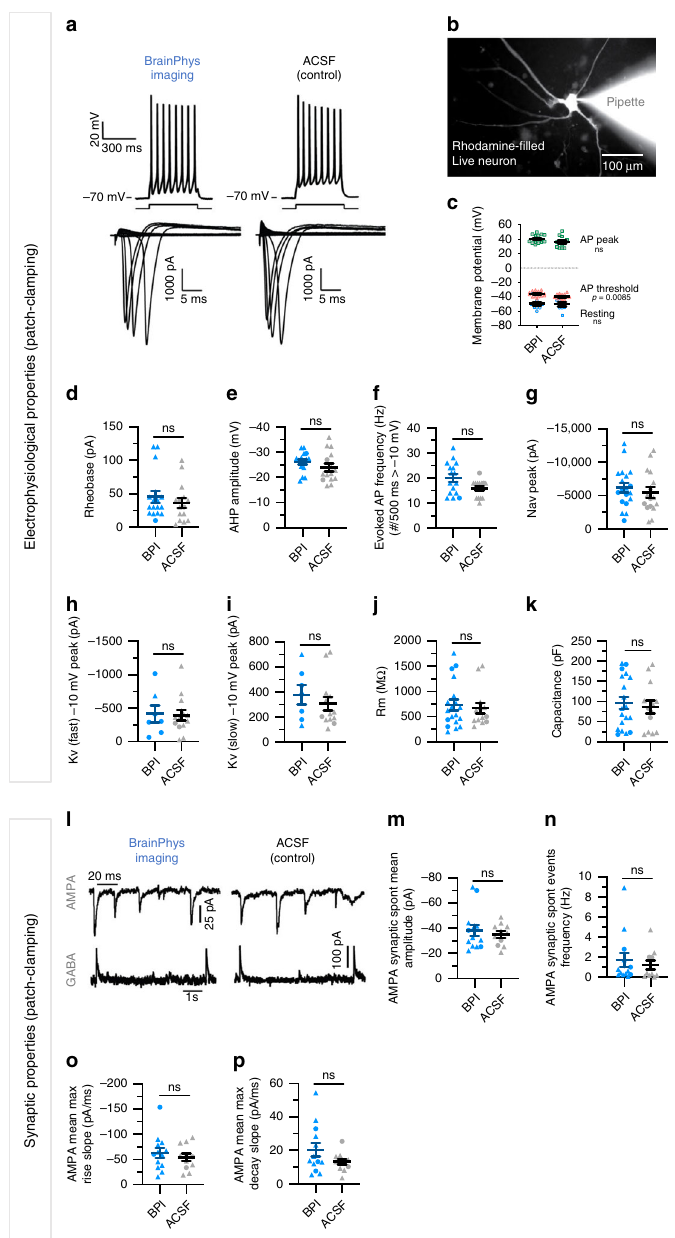
Fig. 4 BrainPhys Imaging supports optimal electrophysiological and synaptic activity of human neurons in vitro. Single-cell patch-clamp recordings of iPSC-derived neurons matured in standard BrainPhys (BP) + supplements medium for >12 weeks, and patch clamped in BrainPhys imaging (BPI) or arti fi cial cerebrospinal fl uid (ACSF). All patch-clamped neurons ( n = 35) included in the analysis were classi fi ed as “ Type-5 ” and patched from a total of